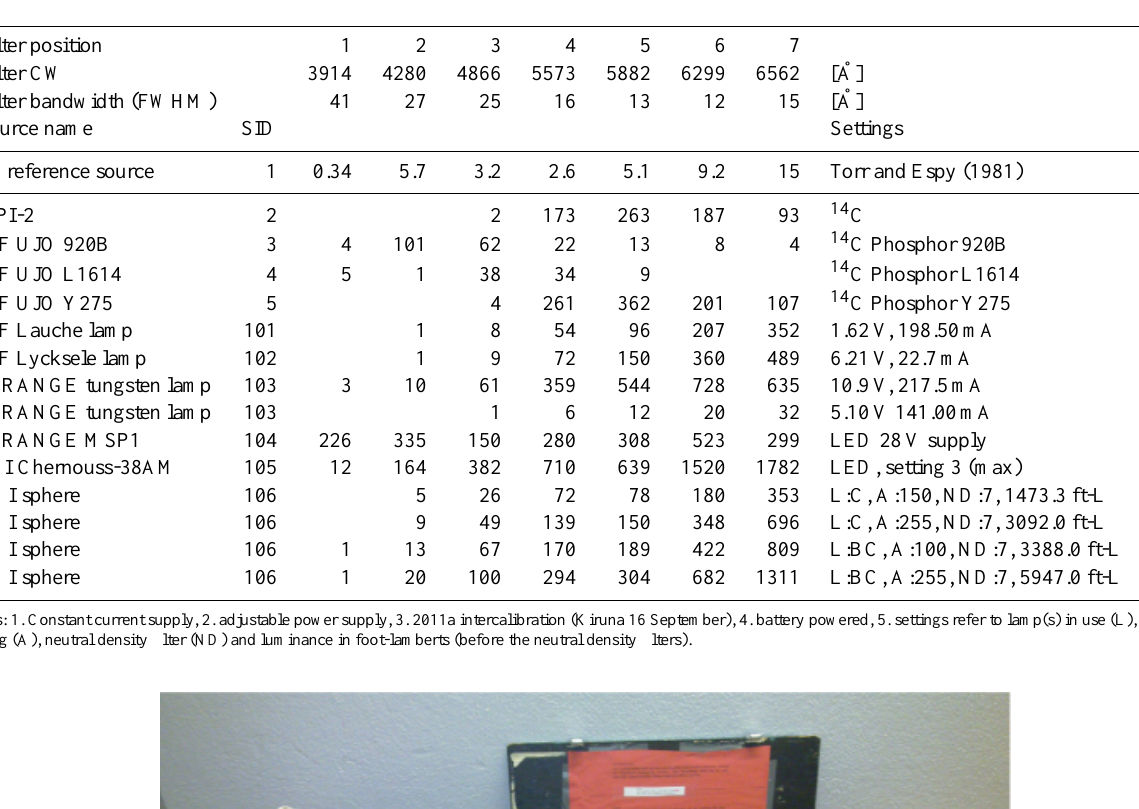
Table 2. Results of the intercalibration workshop. All values are spectral column emission rates in R / ˚A. The absolute calibration values at 3914 ˚A should be considered less reliable (see Sect. 6). Filter transmittance plots are available upon request. SID is source identification number.